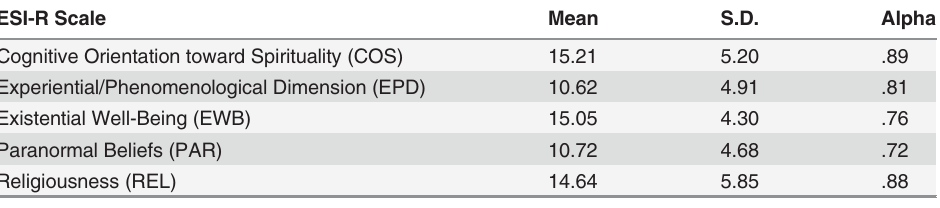
Table 3. ESI-R Dimension Descriptive and Reliability Statistics for Combined Sample (N =